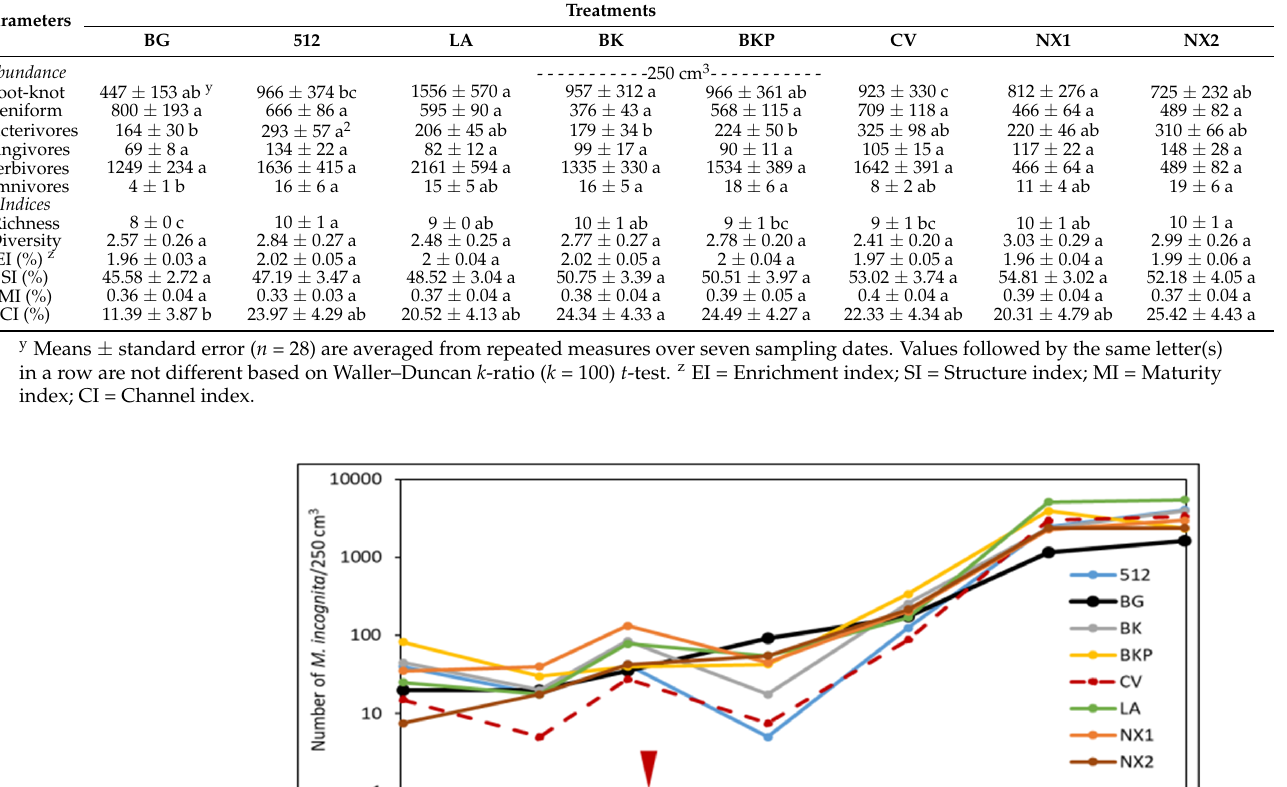
Table 3. Effect of SSgH cover crop on the abundance of nematode trophic groups and nematode community indices throughout the SSgH–eggplant cropping cycle.